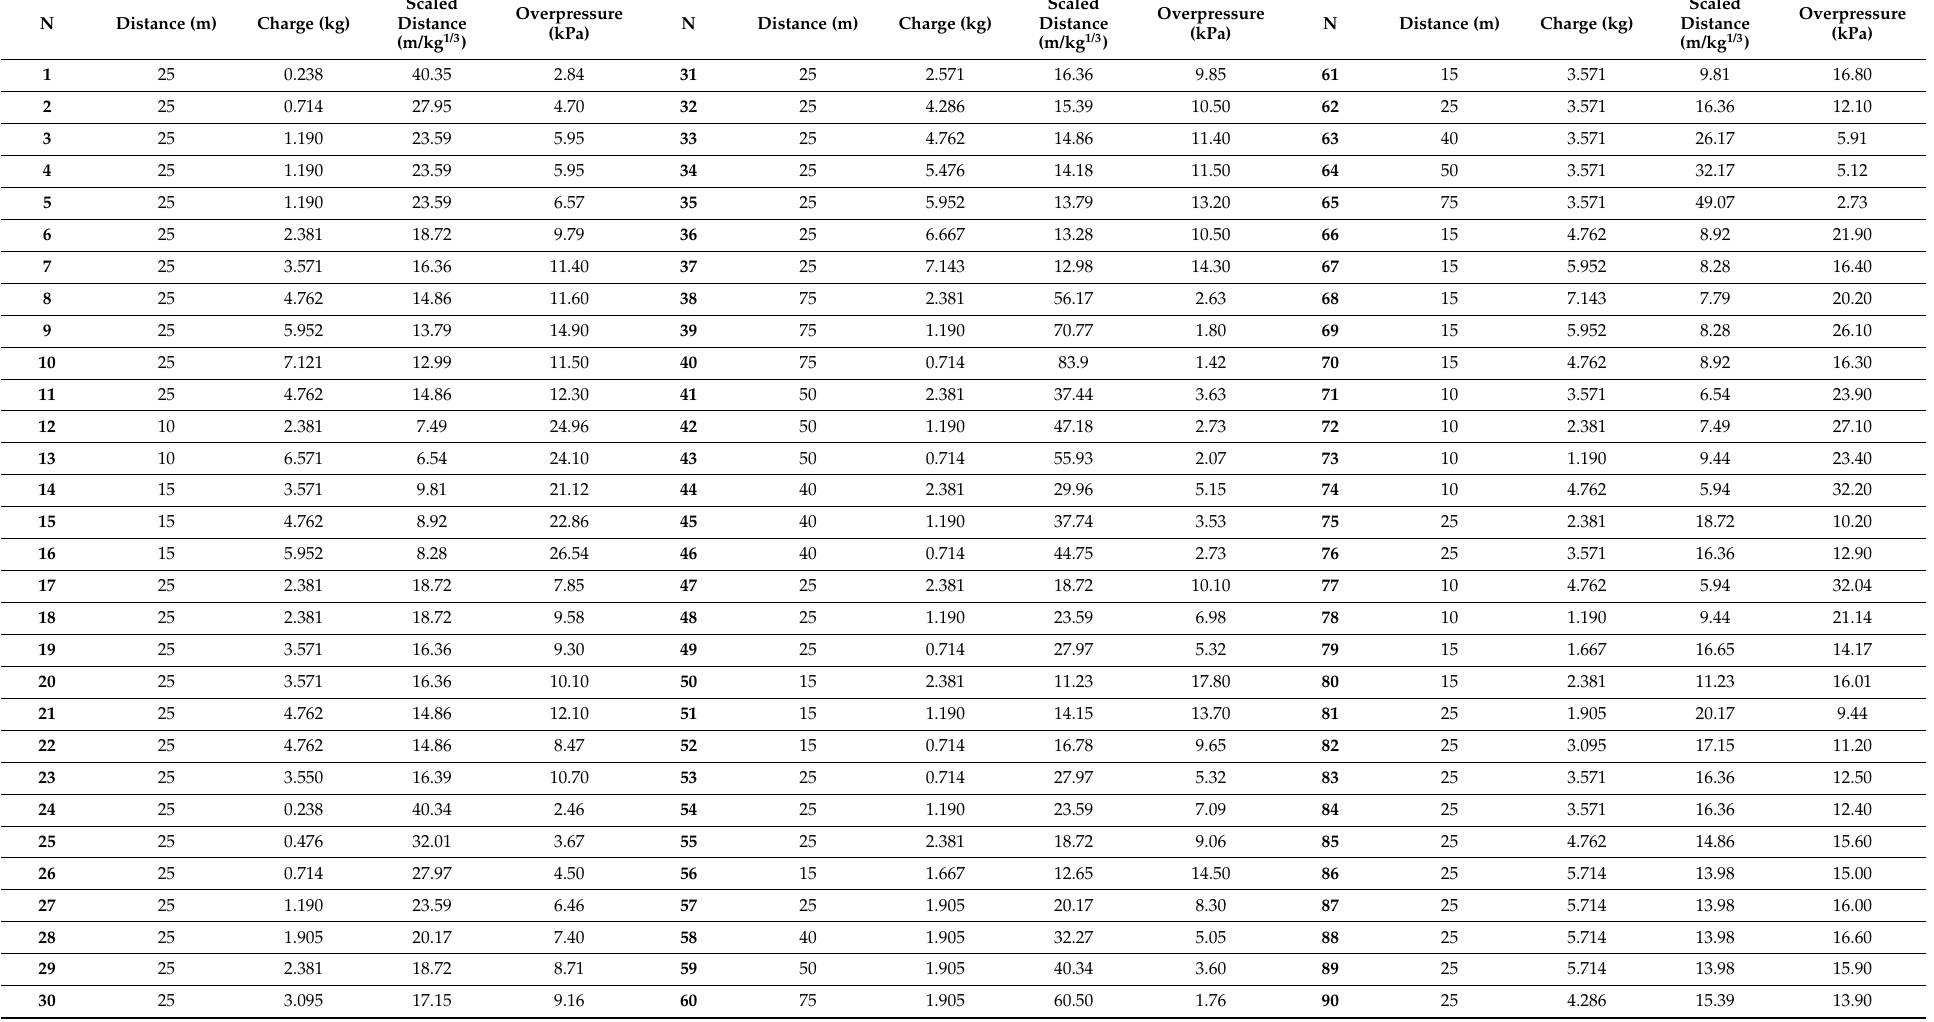
Table 6. Values of scaled distances and air overpressure for each detonated